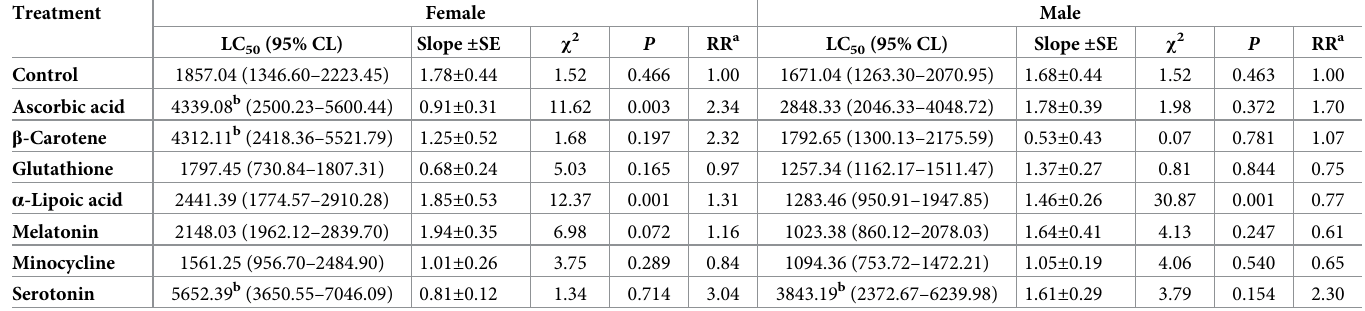
Table 4. LC 50 ( μ g/vial DDT) values with 95% confidence limits (CL), slope, χ 2 , and resistance ratio (RR) for D . melanogaster 91-R adult females and males fed on the indicated antioxidants.